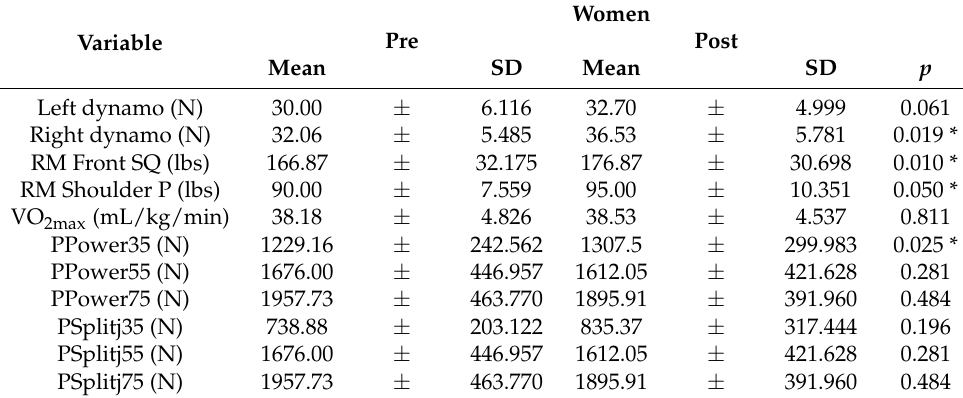
Left dynamo = Left dynamometry; Right dynamo = Right dynamometry; RM Front SQ = Front squat maximum repetition; RM Shoulder P = Maximum repetition of shoulder press; VO 2max = Maximum oxygen consumption; PPower35 = Power in power clean at 35%; PPower55 = Power in power clean at 55%; PPower75 = Power in power clean at 75%; PSplit35 = Power in split jerk at 35%; PSplit55 = Power in split jerk at 55%; PSplit75 = Power in split jerk at 75%; N = Newtons, * = p ≤